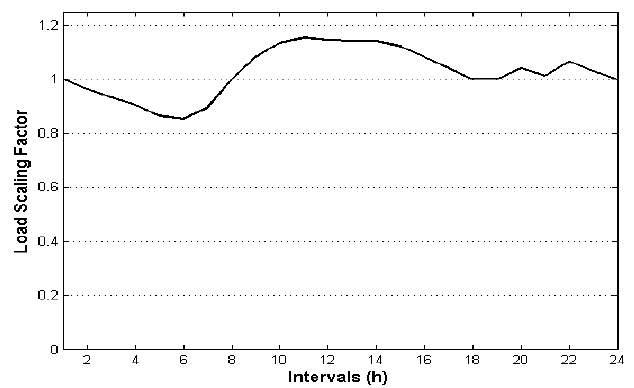
Figure 3. Load scaling factor for 24 h scheduling period.